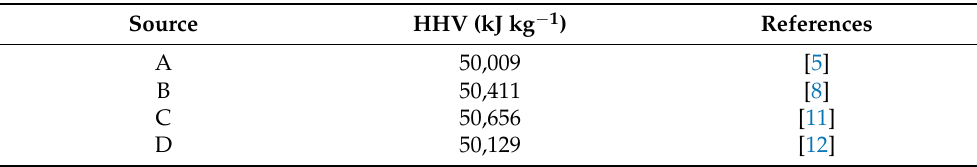
Table 4. Higher Heating Value (HHV) values from different sources used in the sensitivity analysis of the thermal efficiency